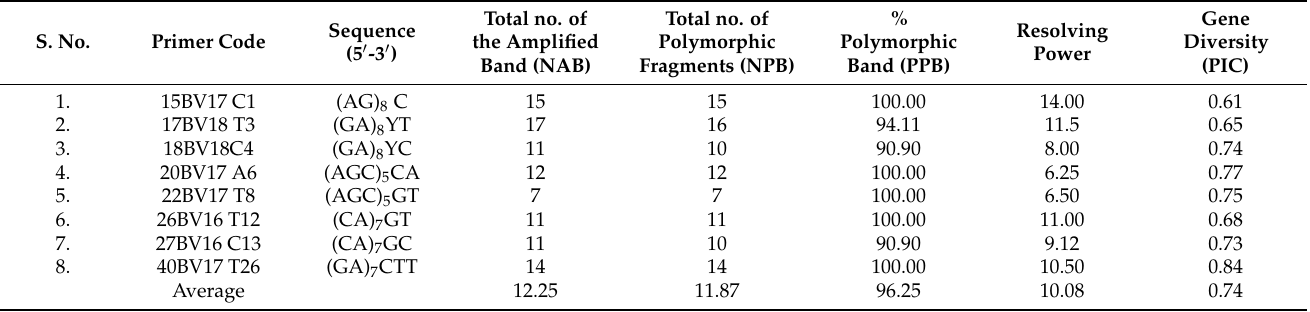
Table 4. ISSR primers employed in the genetic diversity of S. cumini germplasm with their corre- sponding percentage polymorphism, gene diversity, and resolving